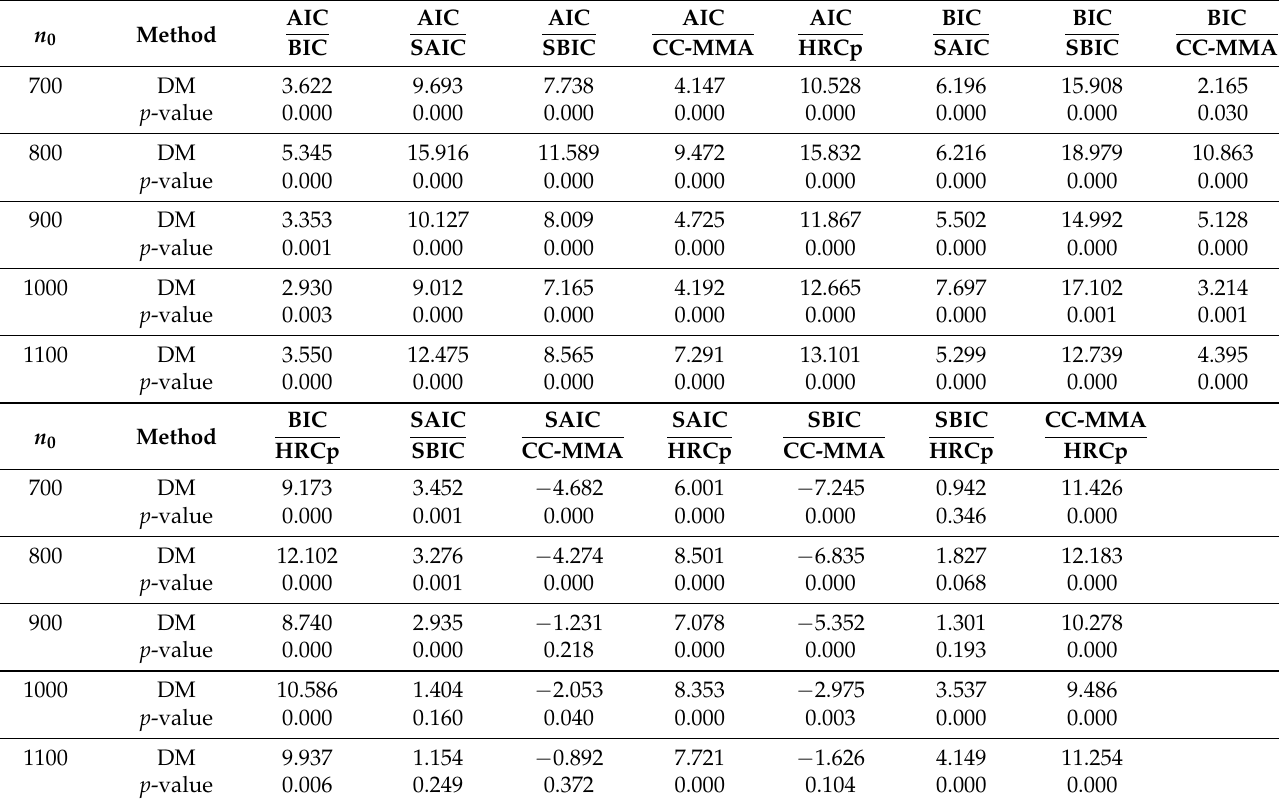
Table 4. Diebold–Mariano test results for the differences in